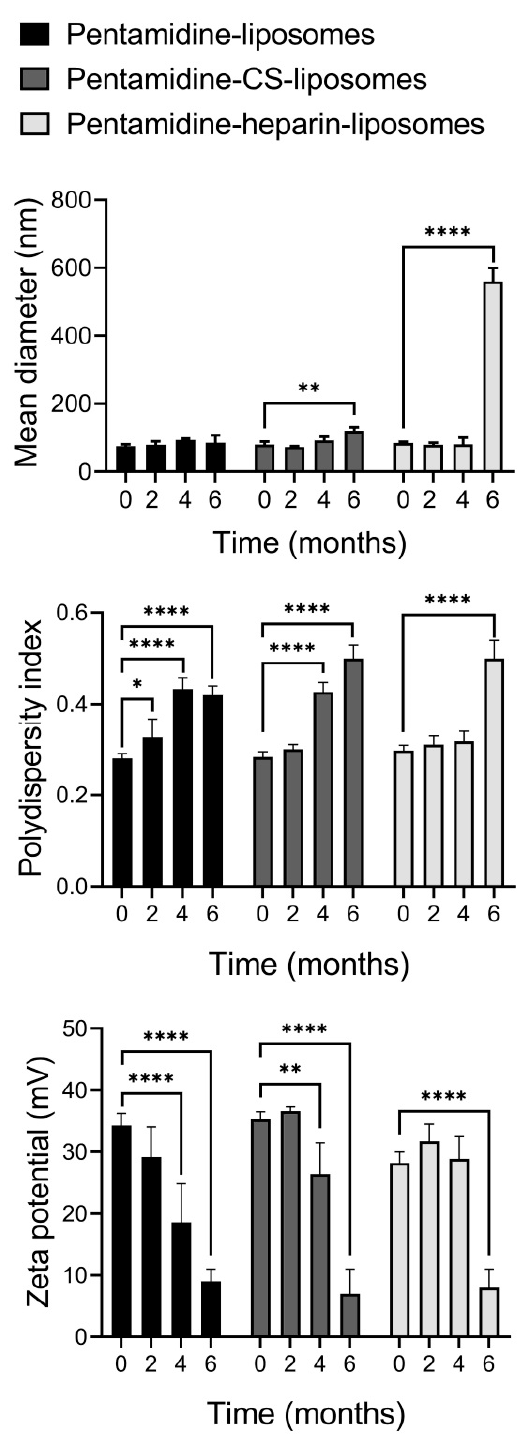
Figure 3. Analysis of mean diameter, polydispersity index and zeta potential of pentamidine-loaded liposomes during 6 months of storage at 4 °C. Mean values ± standard deviations (error bars) are reported ( n = 3). *: p ≤ 0.05; **: p ≤ 0.01; ****: p ≤ 0.0001. The release in PBS of pentamidine from liposomes uncoated and coated with CS or heparin was measured and compared with the free drug in solution using a membrane dialysis approach (Figure 4). Free pentamidine quickly crossed the dialysis membrane, with around 50% of it found in the receptor medium after 30 min and ca. 90% after 2 h, supporting the suitability of this method to evaluate drug release. In contrast, encapsu- lated pentamidine crossed the dialysis bag at a signi fi cantly slower pace, regardless of the used formulation: pentamidine-containing liposomes, either nonmodi fi ed or coated with CS or heparin, released ca. 50%, 75% and 90% of drug after 2, 8 and 40 h, respectively, reaching a complete release at 72 h. Because dialysis quickly removes extraliposomal